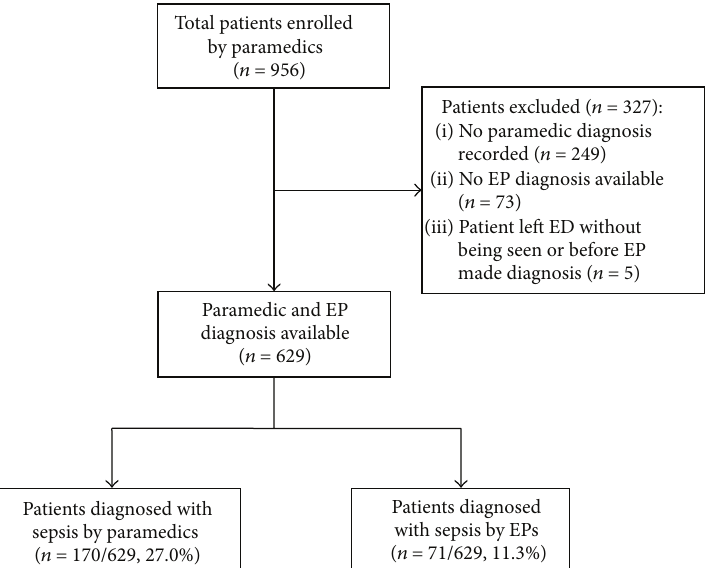
Figure 1: Selection of study participants and identification of sepsis by paramedics and EPs. ED, emergency department; EP, emergency